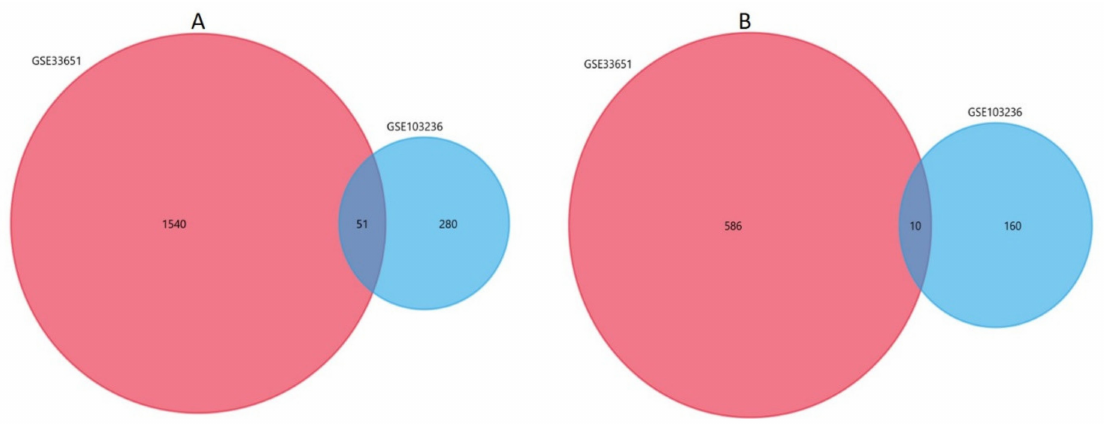
(DEGs) between gastric cancer samples and normal samples.